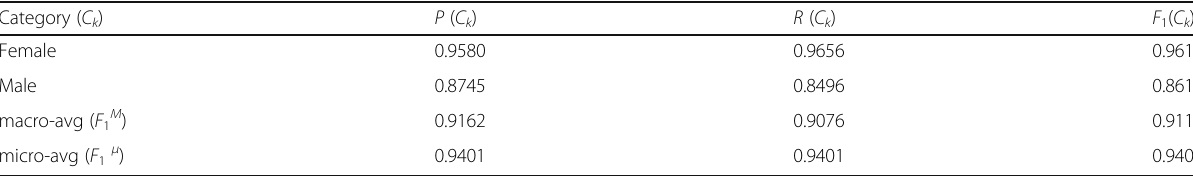
Table 10 Results with norm-TF with cross validation = 5